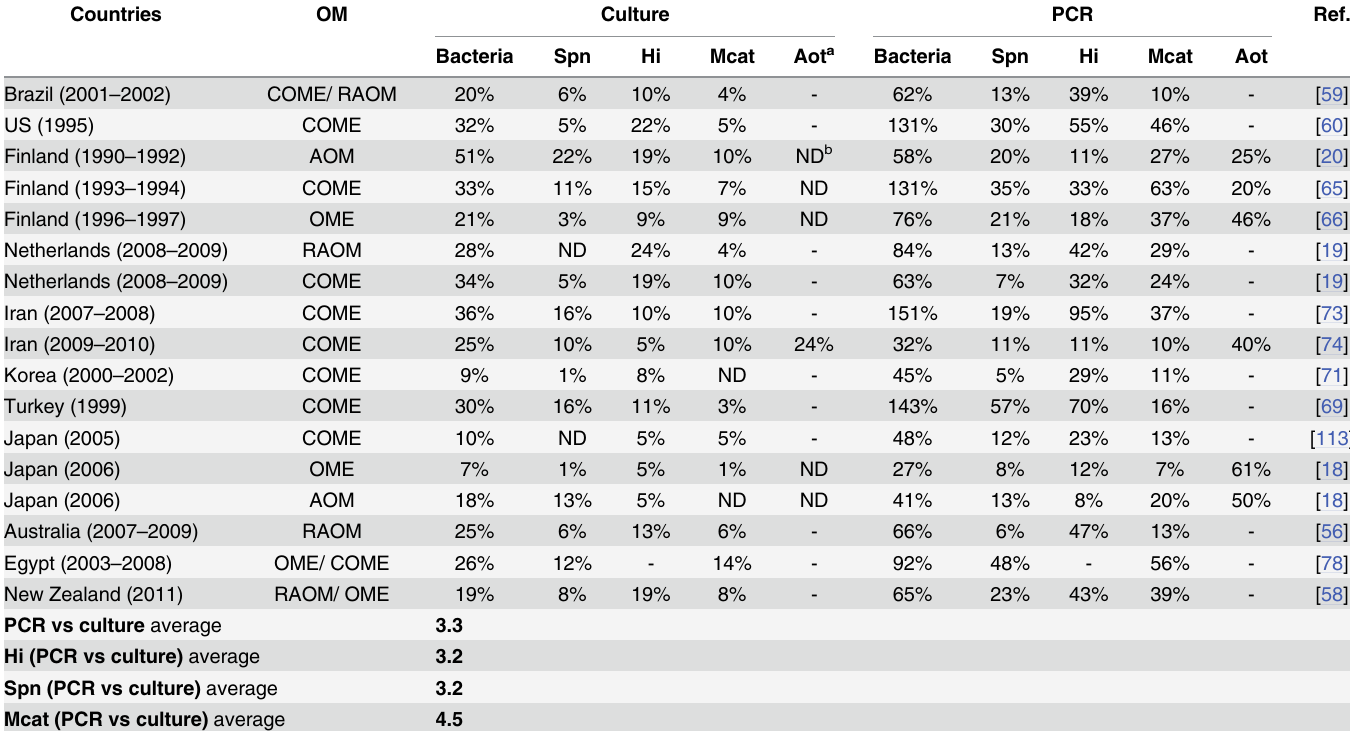
Table 4. Comparison of otopathogen detection in MEF using culture and PCR. Countries OM